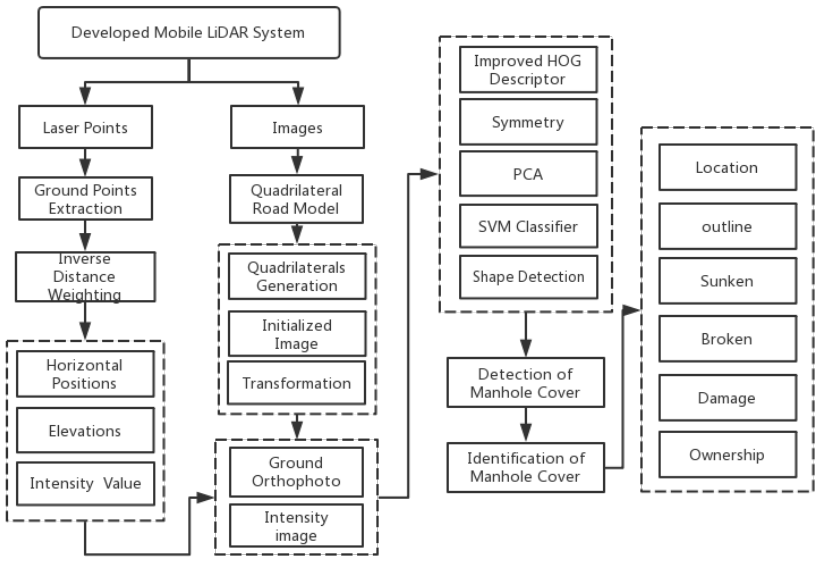
Figure 5. Framework for manhole cover detection and identification.